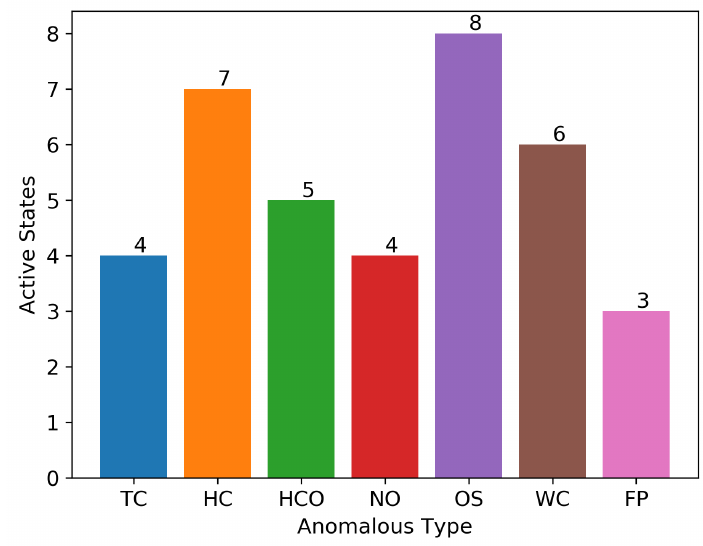
The number of hidden states being active for different anomaly classes using HDP-HMM-AR-moVB method. An active state is one in which at least one observation is assigned to this